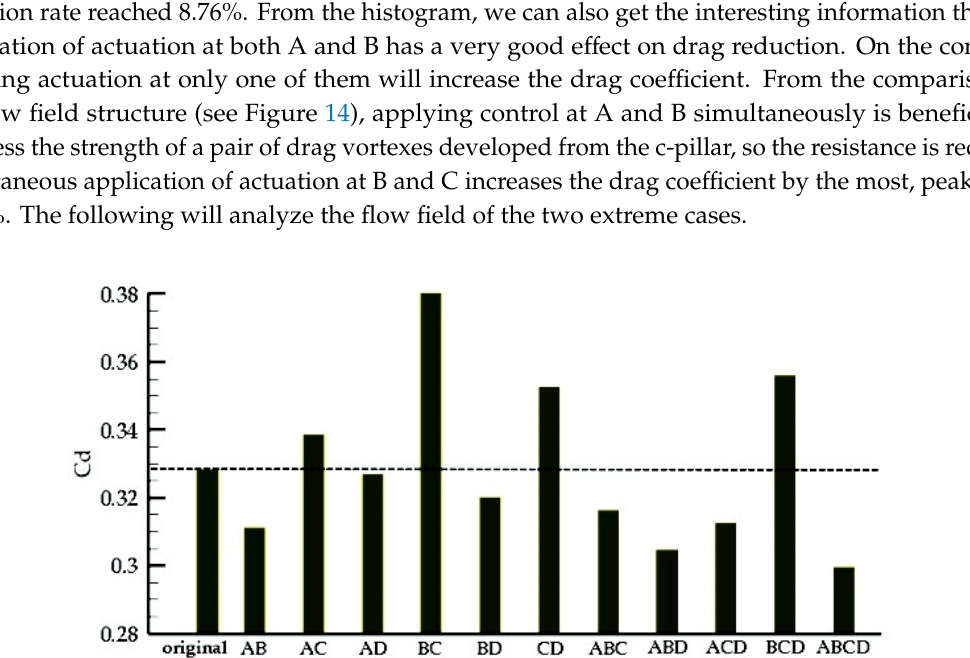
Figure 14. Pressure contour on x = 0.6 m section (15 kV).